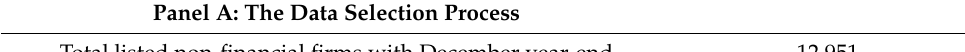
Table 1. The Sample Selection Procedure. Panel A: The Data Selection